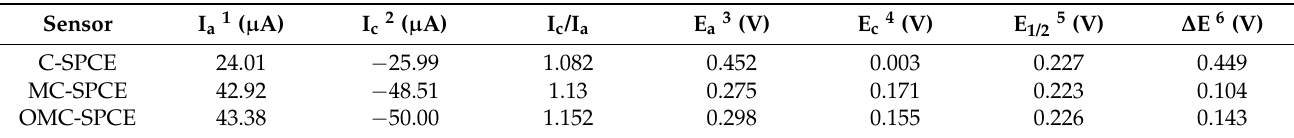
Table 1. Electrochemical parameters obtained by the three sensors by immersion in a K 4 [Fe (CN) 6 ] 1.0 × 10 − 3 M-PBS 0.1 M